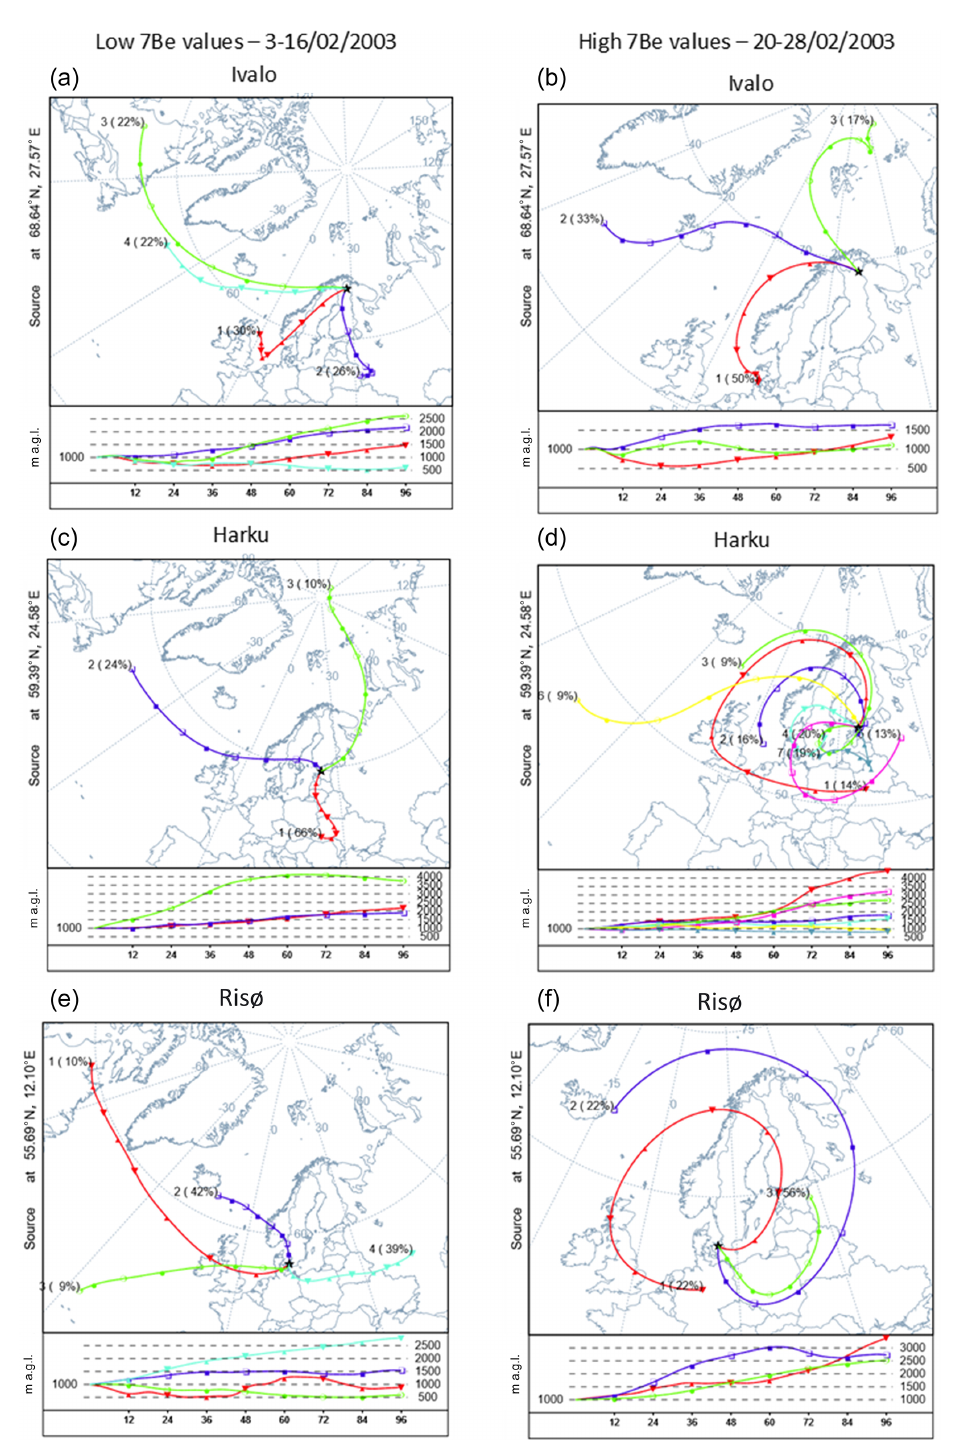
Figure 15. Average trajectory cluster results (centroids) arriving in Ivalo, Harku and Risø at 1000m for low 7 Be values (left: 3–16 Febru- ary 2003) and high 7 Be values (right: 20–28 February 2003), respectively. The stations are ordered by latitude from top to bottom (coordinates of the receptor site are provided on the left of each plot). The right numbers between brackets in the centroids are the percentage of complete trajectories occurring in that cluster, and the left numbers are an identification number of the centroid. In each panel, the upper plot shows the average latitude–longitude plot of each trajectory cluster, while the bottom panel presents the time vs. trajectory average altitude